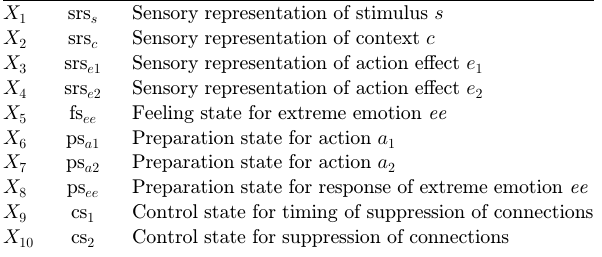
Table 1. Explanation of states in the